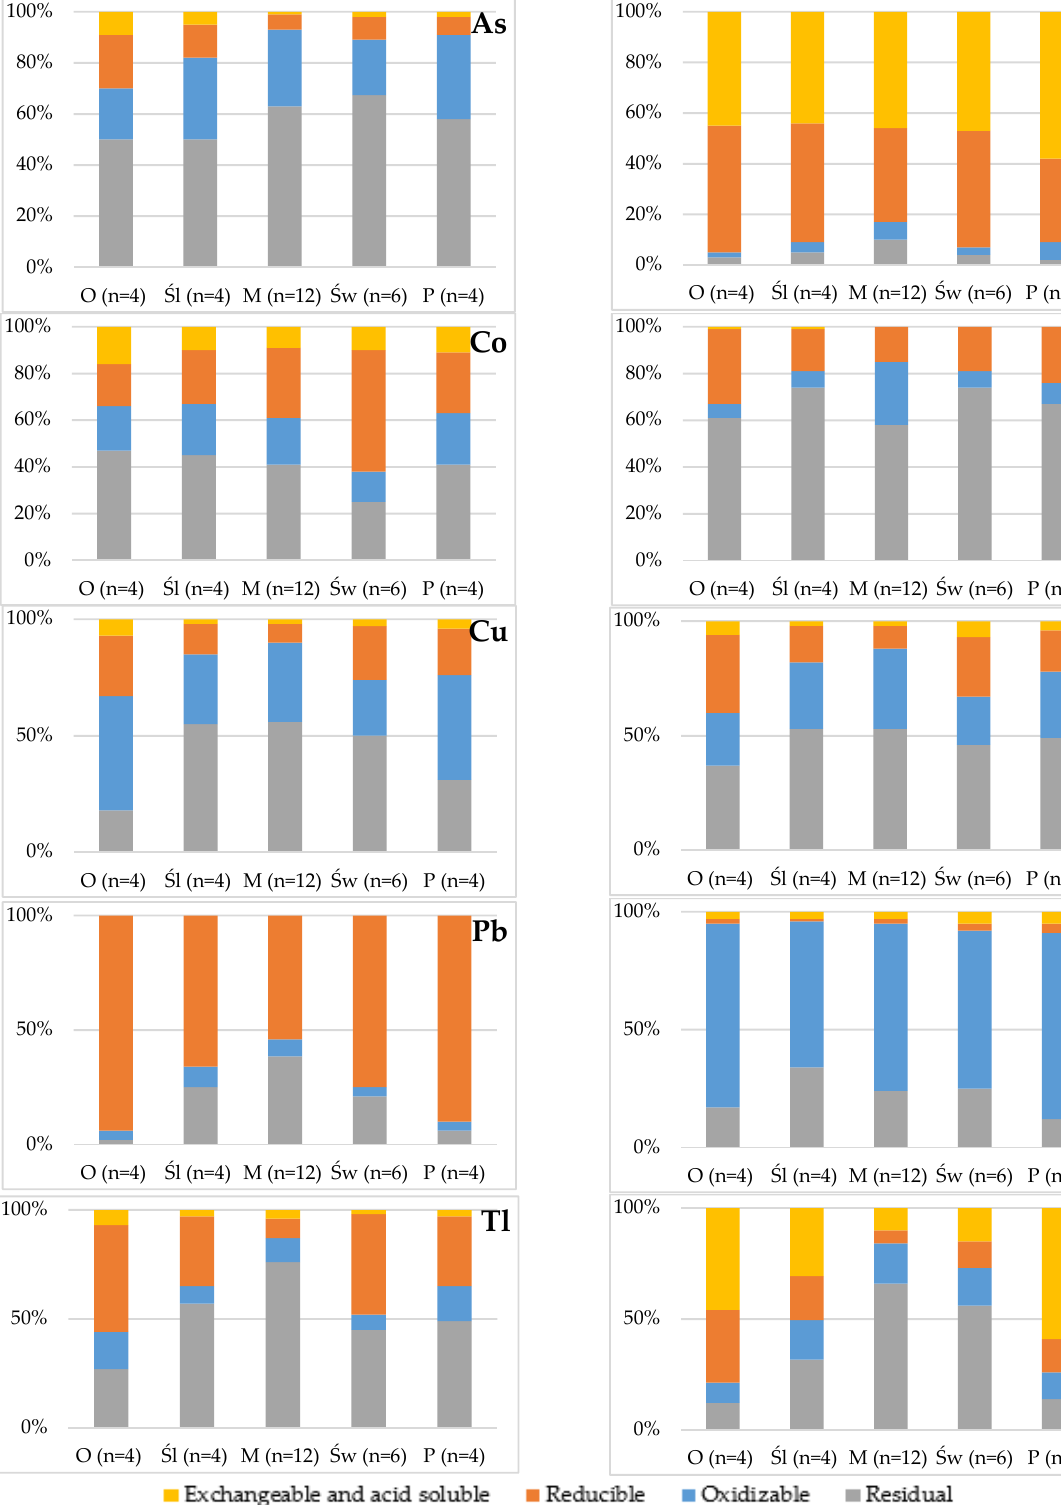
Figure 3. PHE content (%) from the Community Bureau of Reference (BCR) extraction procedure as the relative ratio of a fraction to the summarized extracted fractions expressed in the agricultural soils of southern Poland; O—Opolskie, Ś l— Ś l ą skie, M—Ma ł opolskie, Ś w— Ś wi ę tokrzyskie, P— Podkarpackie. Exchangeable and acid soluble (BCR F1 ): Cd > Zn > Co > Ni = Sb > Cu > Tl > As > Cr =